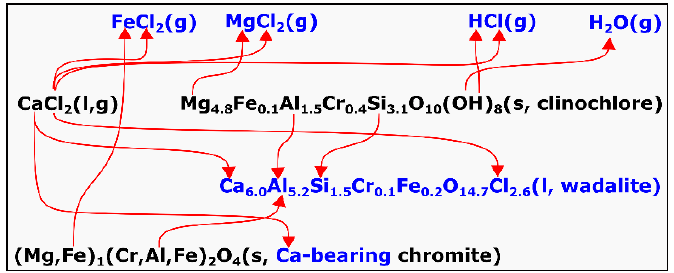
Figure 15. Illustration of the proposed interactions among CaCl 2 , clinochlore, and chromite.